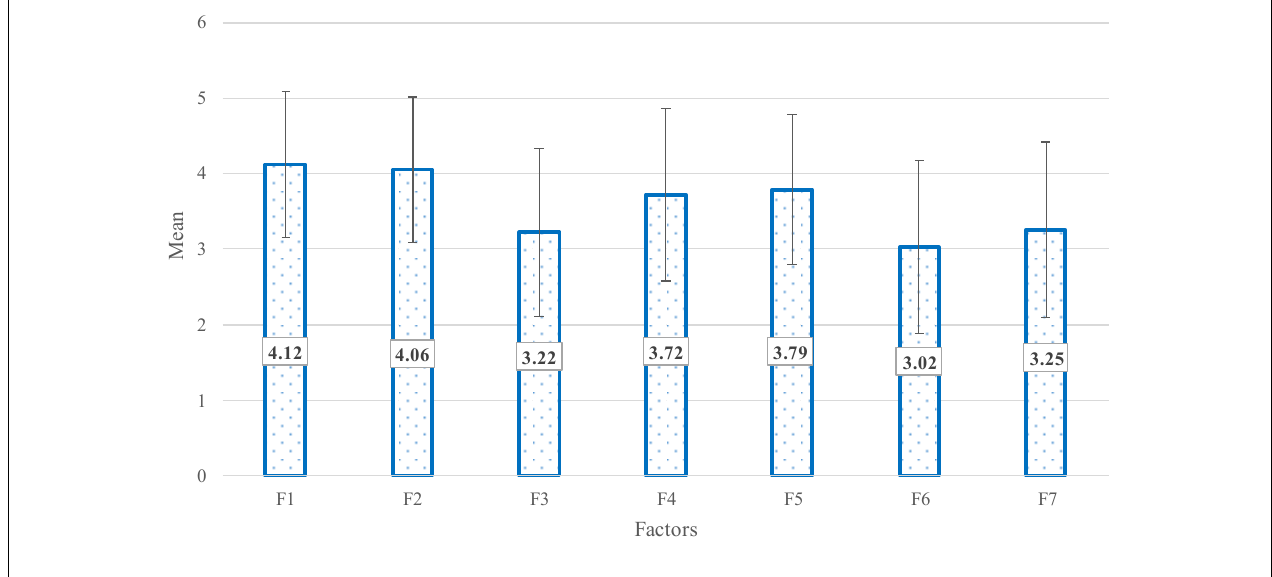
FIGURE 4 | Means of each factor in FCV19 scale ( N = 567).